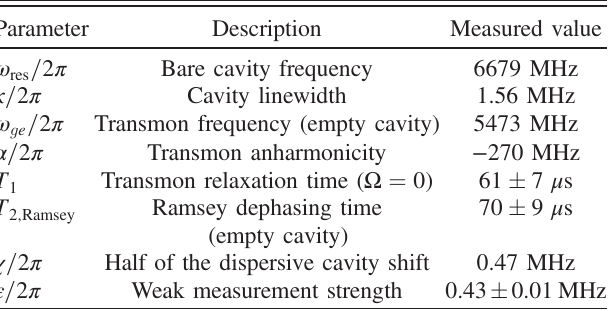
TABLE I. Calibrated resonator and qubit parameters for the device used in this work. Note that ω and ω are the bare ge res readout resonator and qubit frequencies, respectively, and that T 1 and T 2 were measured without a weak measurement ; Ramsey tone ( ε = 2 π ¼ 0 ). The error bars on T 1 and T 2 reflect ; Ramsey the standard deviation of 100 repeated measurements during a 3 h